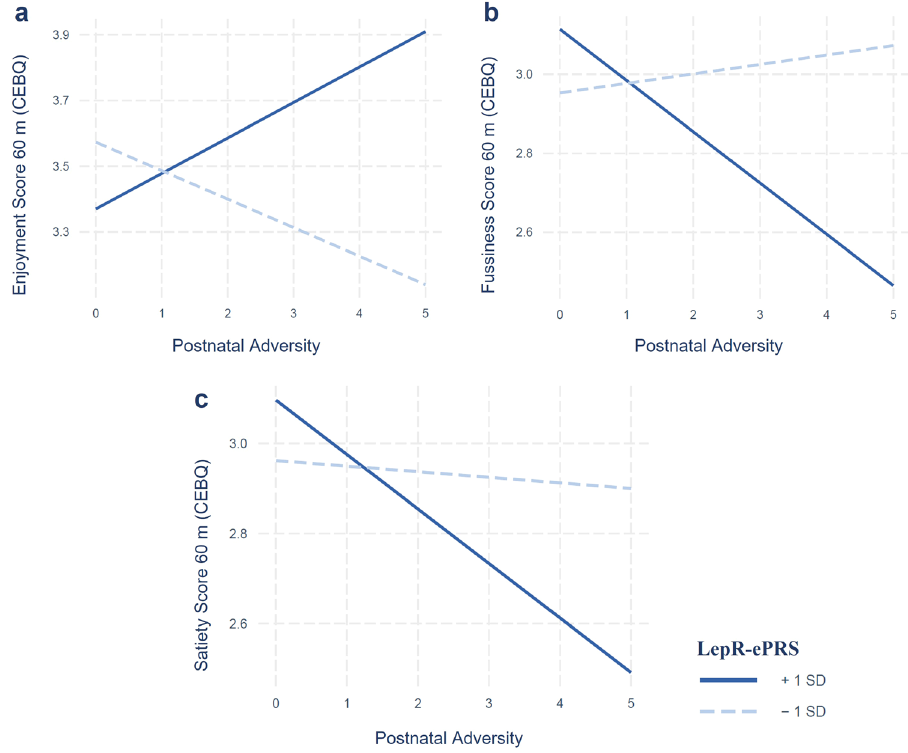
Fig. 2 Interaction effect between the Postnatal Adversity Score and the Prefrontal-based LepR-ePRS in the GUSTO cohort. Interaction effect between the Postnatal Adversity Score and the Prefrontal-based LepR-ePRS on a ) Enjoyment score, b ) Food fussiness score, and c ) Satiety score at 60 months in the GUSTO sample. Higher postnatal adversity exposure is associated with lower satiety, higher food enjoyment and lower food fussiness as the ePRS increases. GUSTO cohort ( N = 439). Linear regression analyses followed by simple slope